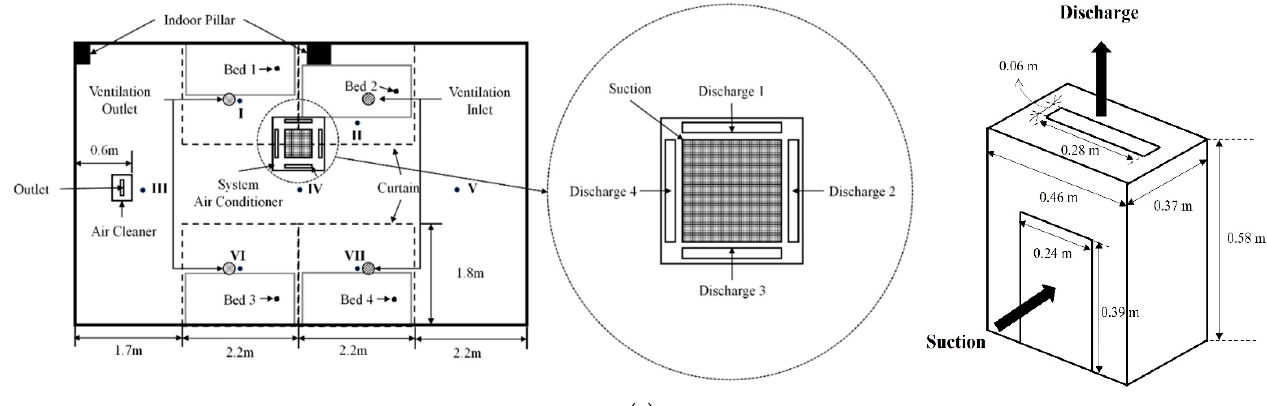
Figure 1. Composition of the four-bed ward laboratory: ( a ) laboratory photograph; ( b ) isometric view; ( c ) floor plan.